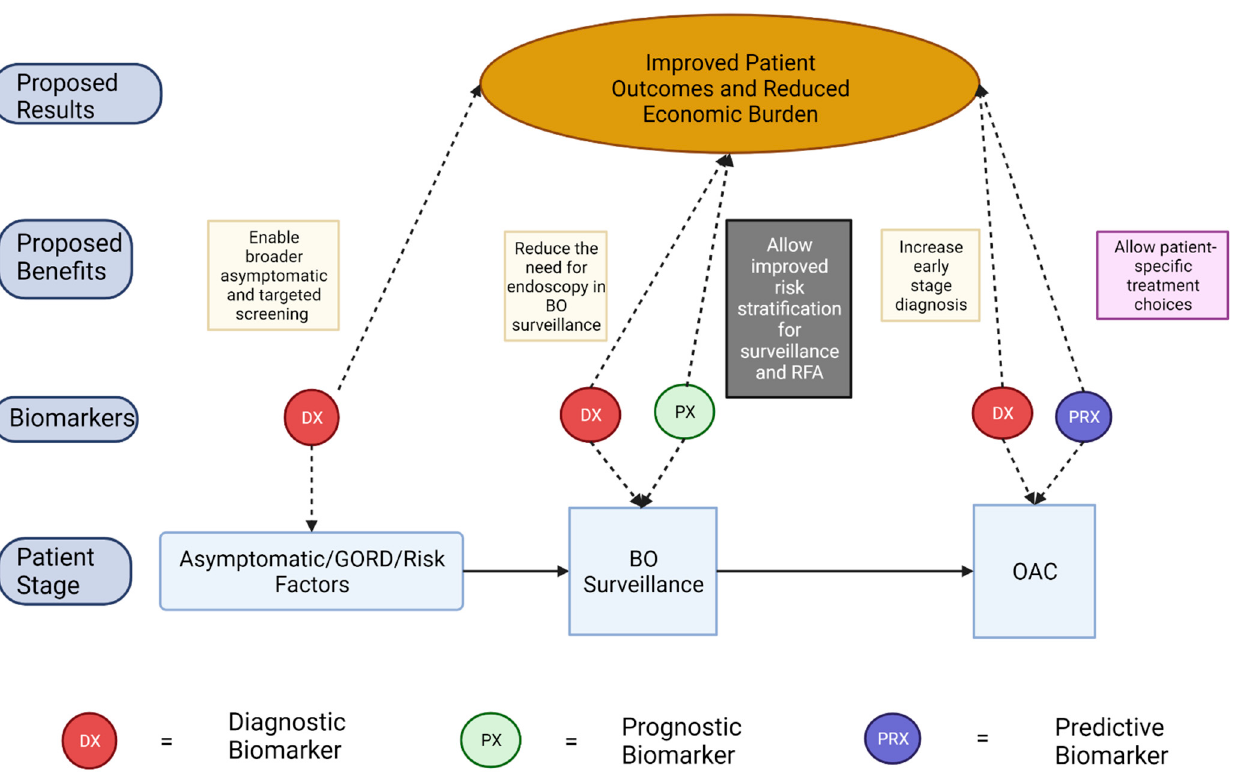
Figure 1. The influence of diagnostic, prognostic and predictive biomarkers on outcomes along the BO-OAC disease sequence.